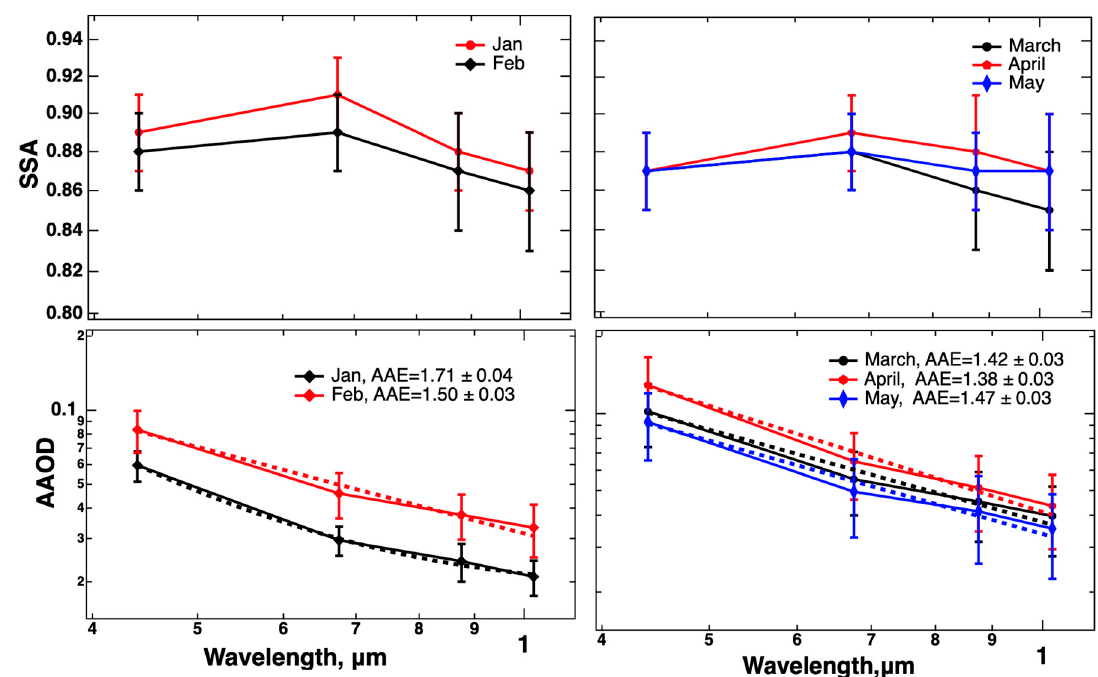
Figure 7. Monthly mean spectral SSA ( top two figures ), averaged within the months of the study period of years 2010–2018, from January to May, along with AAOD ( bottom two figures ) in the logarithmic scale. The dotted lines are the linear fit of spectral AAOD in the logarithmic scale.